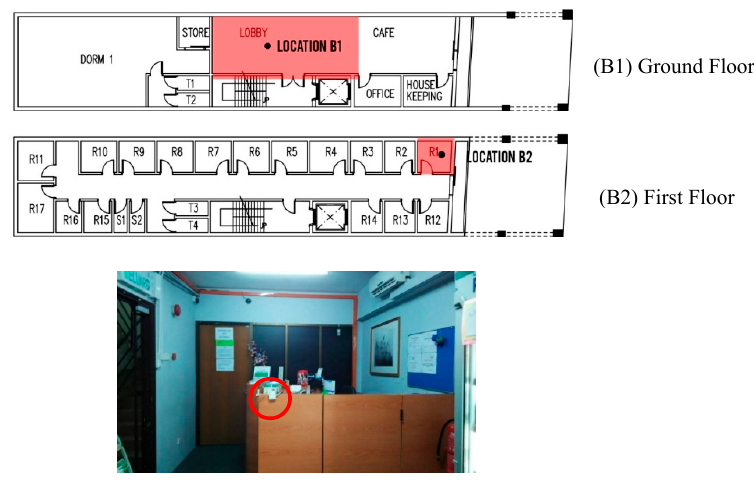
Figure 5. Location of data loggers in Building